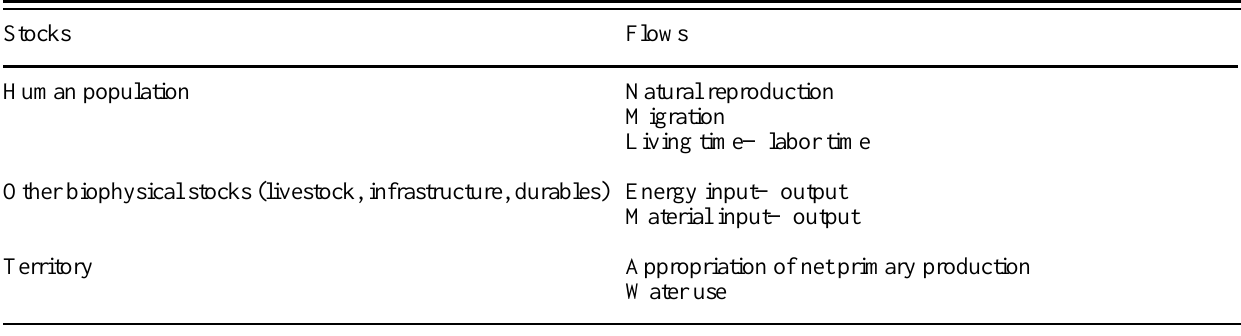
Table 1. Biophysical dimensions of social systems.